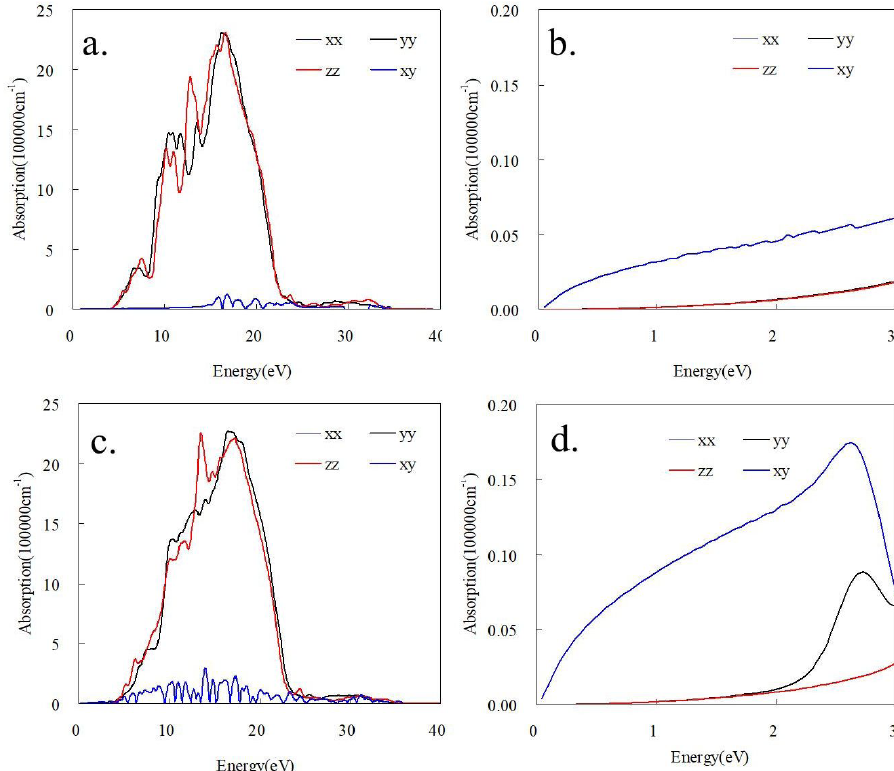
(a), NaSbO under visible light (b), ANS Catalyst (c), ANS Catalyst under 3 3